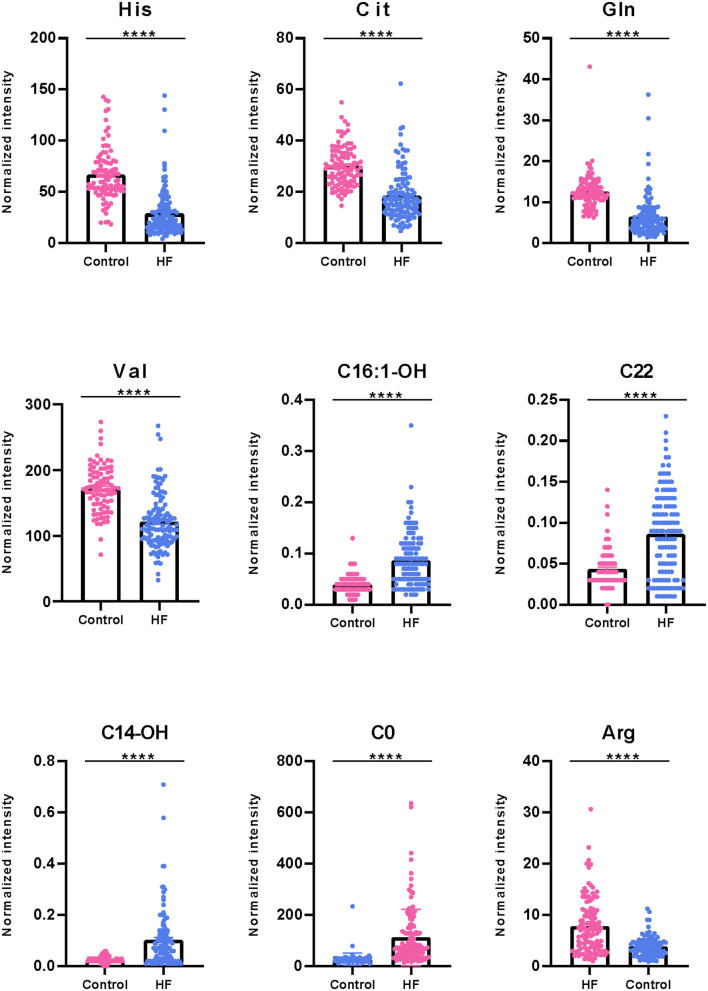
Boxplot of significantly differential metabolites between HF patients and control group. Some representatively differentiated metabolites with P < 0.05 were showed (****P < 0.0001).